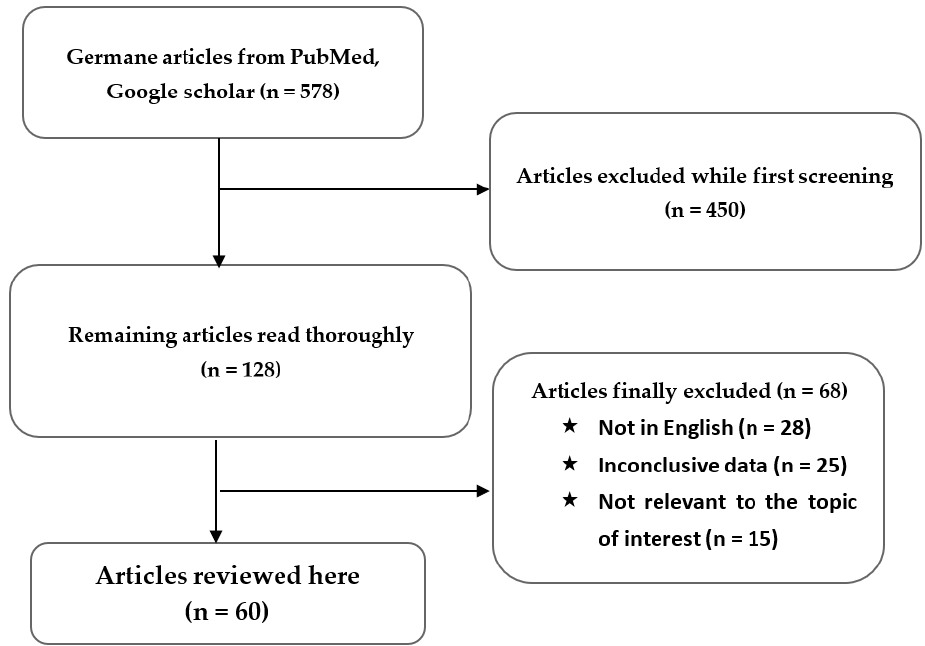
Figure 3. Flow diagram of the literature search and study choosing procedure.